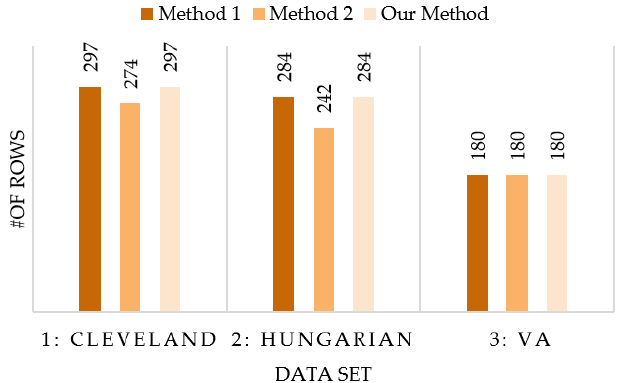
Figure 9. Number of Rows.